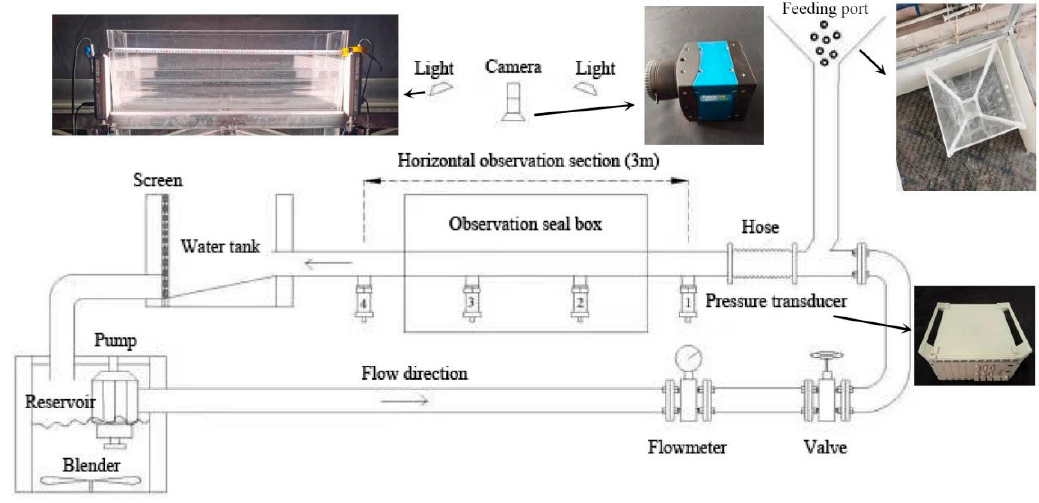
Figure 3. Solid model generalization diagram.